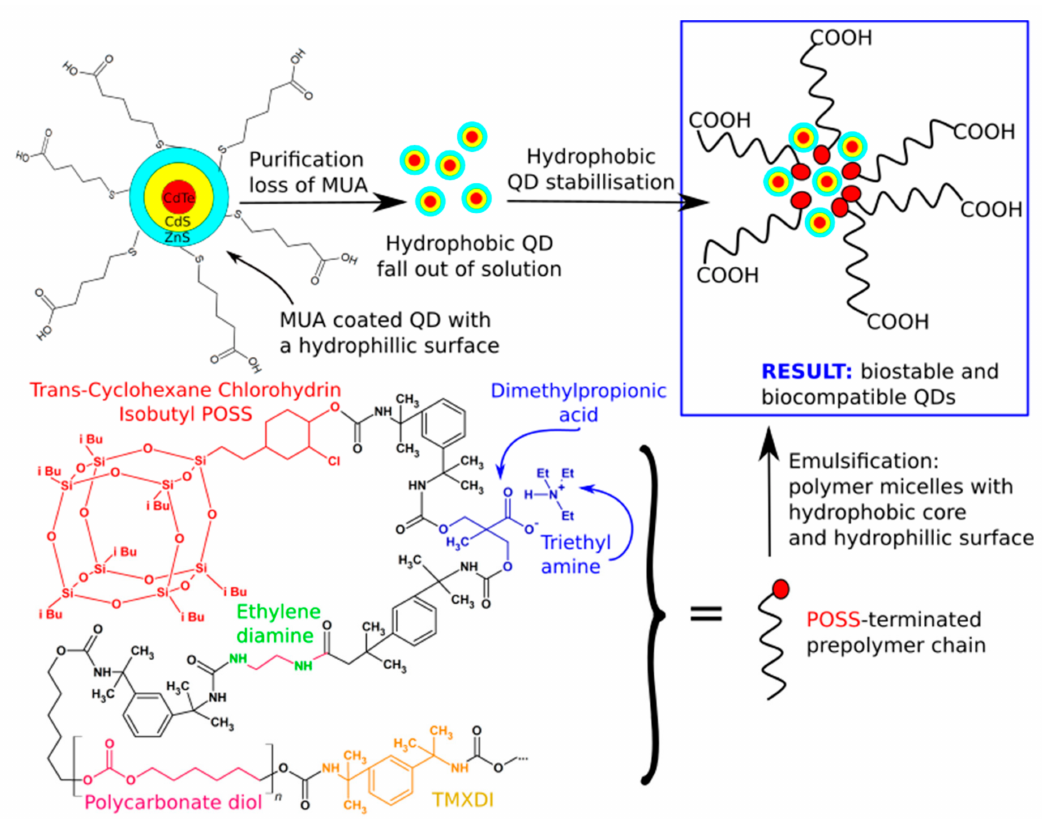
Figure 5. Schematic representation of the POSS terminated prepolymer and emulsification of QDs. Rizvi, S.B.; Yang, S.Y.; Green, M.; Keshtgar, M.; Seifalian, A.M. (2015) Bioconjug. Chem,